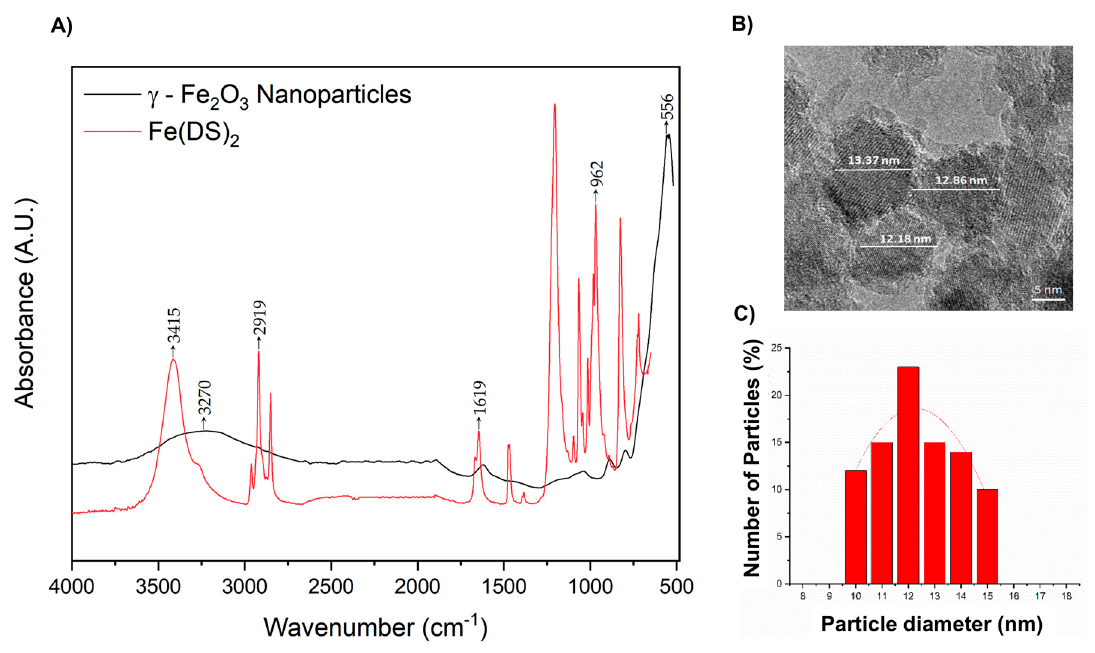
Figure 1. ( A ) The Attenuated Total Reflection Fourier-Transform Infra-Red (ATR-FTIR) spectroscopy spectrum of the γ -Fe 2 O 3 iron oxide nanoparticles (IONPs), in comparison to the Fe(DS) 2 starting material. ( B ) Transmission electron microscopy (TEM) images of IONPs. ( C ) The particle size distribution determined from the average of ~100 measurements of particles.